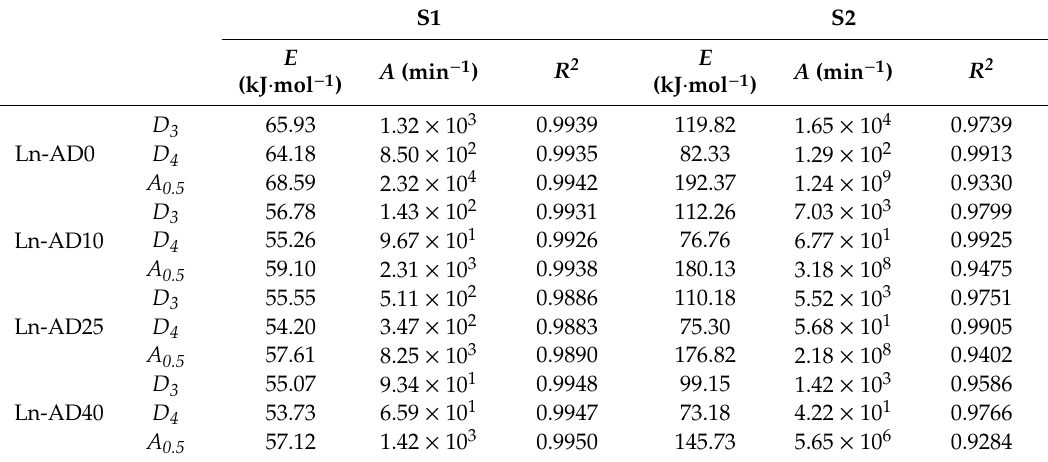
Table 5. The kinetic parameters of lignite and digestate with di ff erent AD